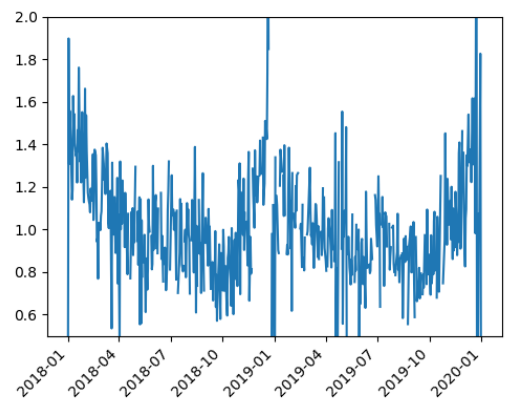
Figure 11. Weekly pattern of R agg estimated with the C/DiffT method vs Nielsen weekly estimations. The plot shows the values of R agg averaged per day of the week, normalised to sum to 1. Blue line: weekly pattern according to our estimations. Yellow line: weekly pattern according to Nielsen.